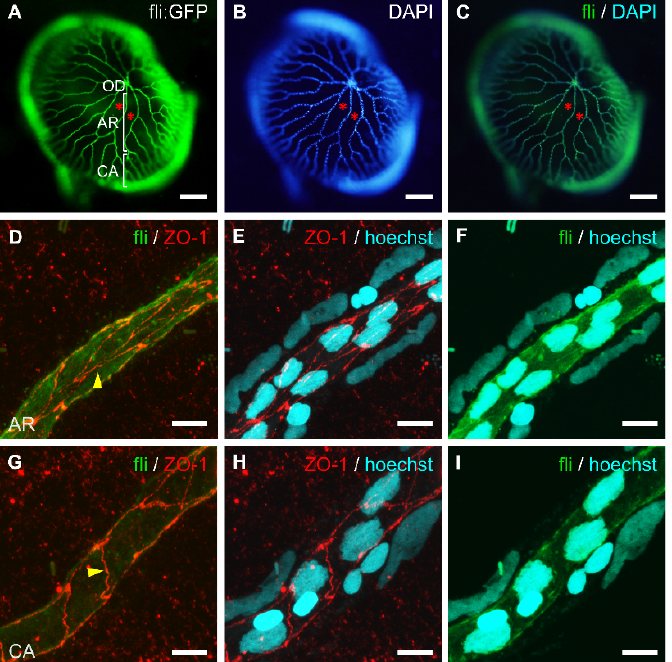
Figure 2. The cellular structure of whole-mount retinal vessels isolated from adult transgenic zebrafish, Tg[fli1:EGFP] . The vessel-specific expression of GFP ( A ) and nuclear staining with DAPI ( B ) in the retinal vasculature. ( C ) Merged image of ( A , B ). Retinal vessels from the optic disc (OD) branched out into the arterial region (AR) and then the capillary area (CA). Asterisks indicate membrane regions between blood vessels. ( D – I ) Immunofluorescent labeling of tight junction protein (ZO-1, red), nuclear staining (Hoechst, blue), and GFP expression (green) in different retinal vessel regions; arterial region ( D – F ) and capillary area ( G – I ). Endothelial cells are elongated and their long axis is parallel to the line of the blood vessel. Arrows show cellular junctions between endothelial cells. Scale bars; 150 μ m for ( A – C ), 20 μ m for ( D – F ), and 10 μ m for ( G – I ).